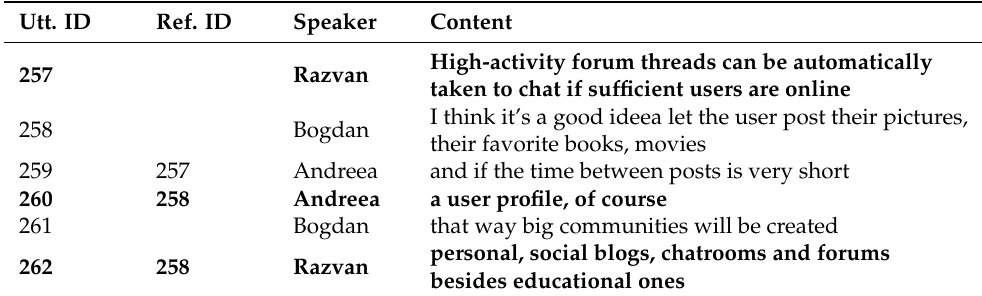
Table 1. Fragments extracted from conversations showing exact matching (Semantic link is high- lighted in